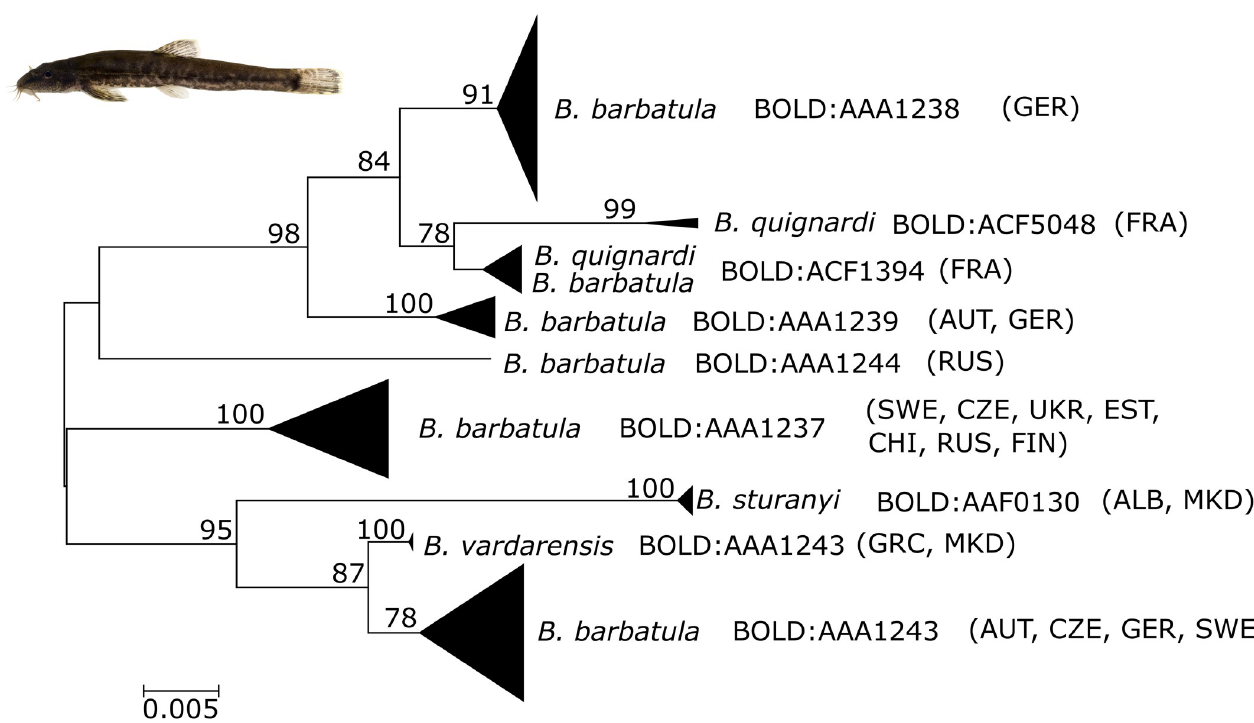
Fig 4. NJ tree of European Barbatula species. Phylogeny of European Barbatula species based on COI barcode sequences available on BOLD and from this study. Species names and BINs are given, countries of origin are indicated by acronyms in parentheses.